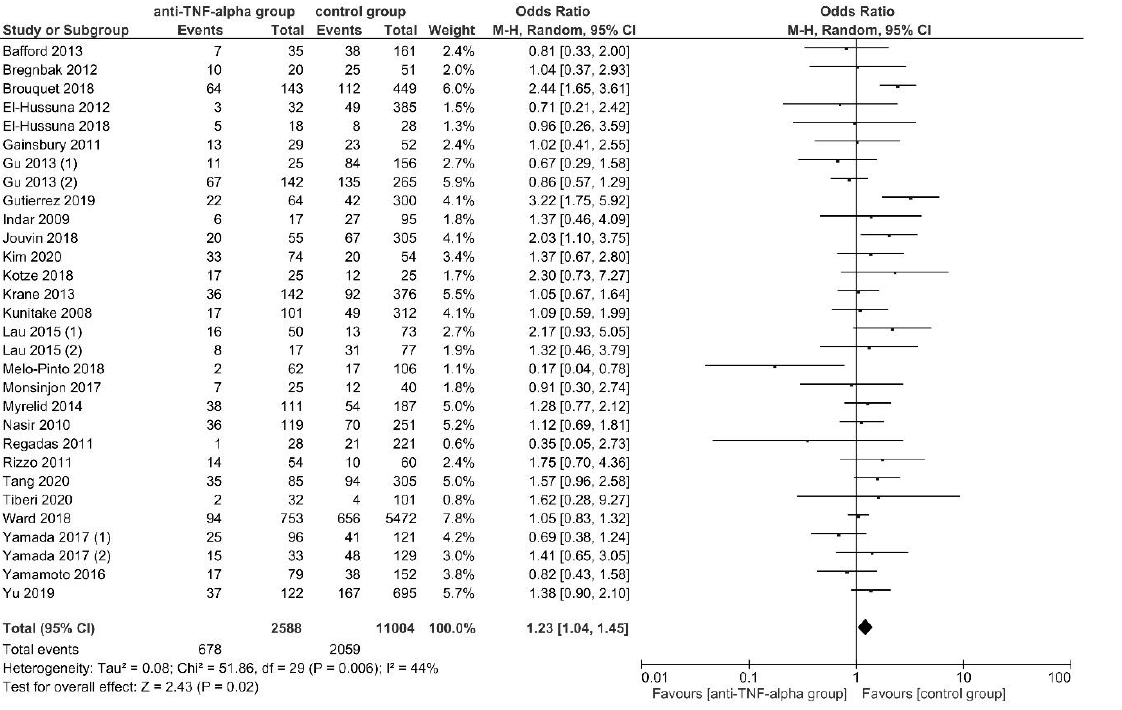
Figure 2. Random-effects model meta-analysis for 30-day overall postoperative complications in the anti-TNF- α (intervention) and control group. Forest plot of all studies included. [21 – 23,47 – 49,51,52,54 – 59,61 – 63,67,69,70,74,75,81,86,89 – 91]